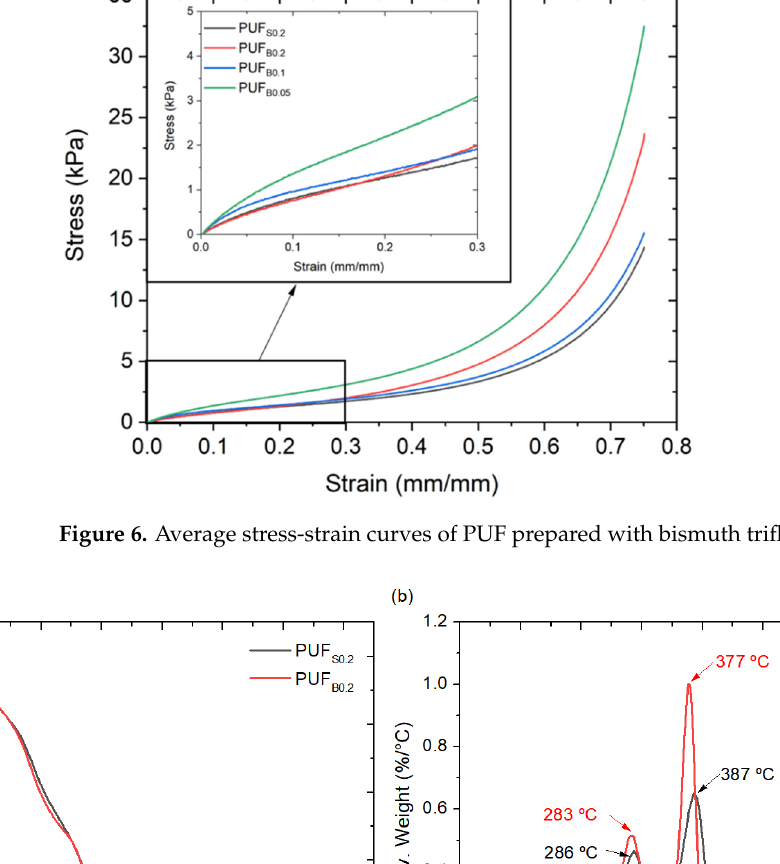
Figure 6. Average stress-strain curves of PUF prepared with bismuth triflate and stannous octoate.